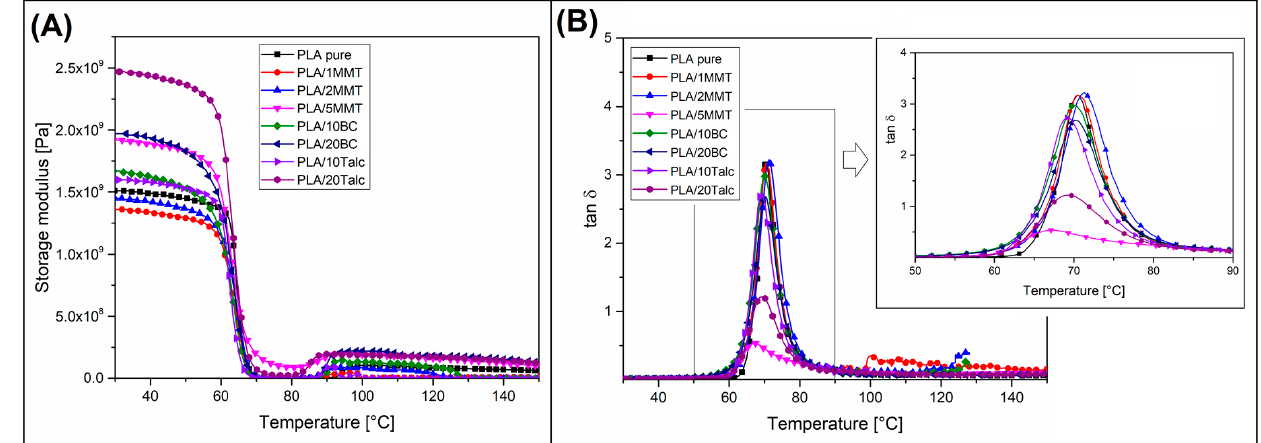
Figure 4. The results of the DMTA analysis. ( A ) storage modulus plots; ( B ) tan δ plots.